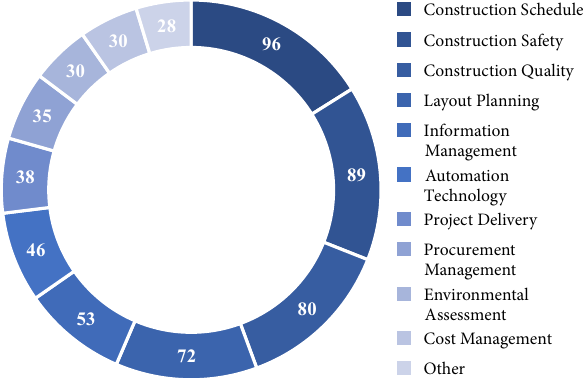
Figure 8. Distribution of BIM use at the construction